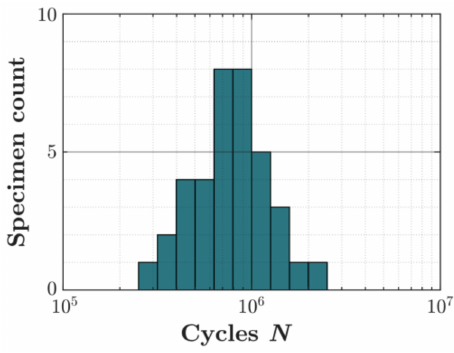
Figure 6. Scatter of the uniaxial fatigue test